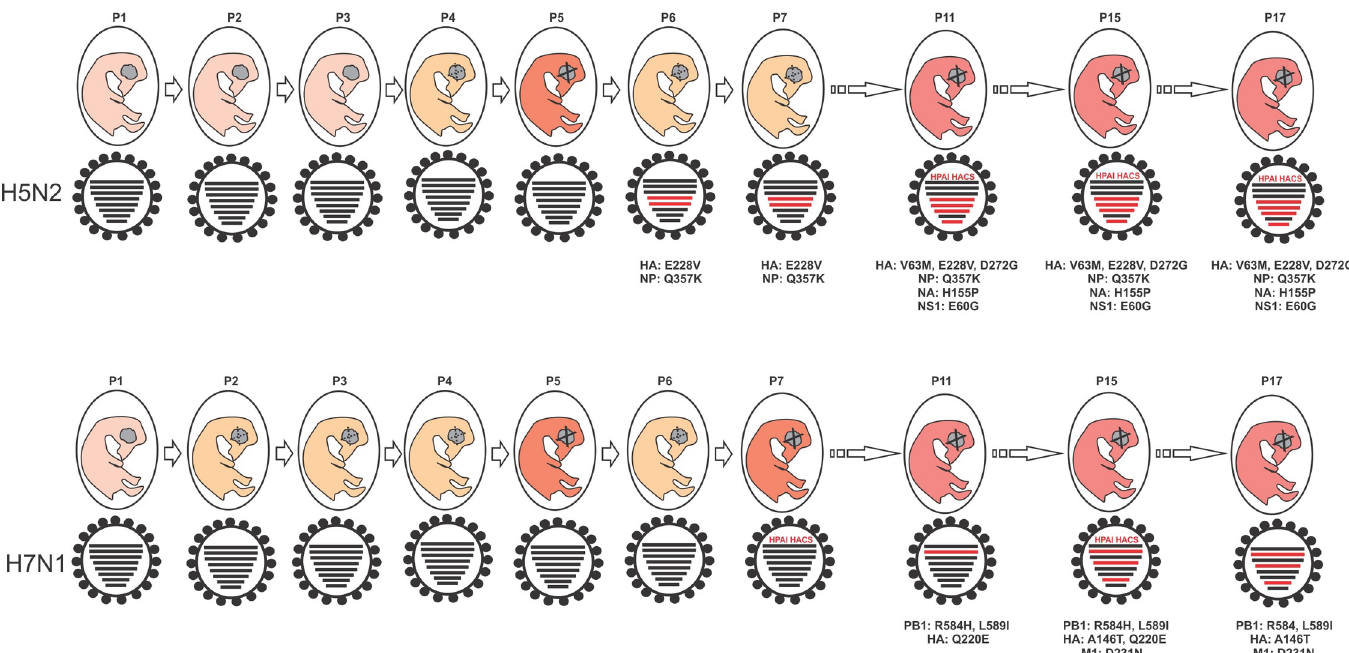
Fig 2. Schematic overview of the pathogenicity of H5N2 and H7N1 LPAI viruses, the emergence of potential virulence markers and the detection of multi-basic hemagglutinin cleavage sites (MB HACS) in the viral sub-population after seventeen passages in 14-day old ECEs. Pink embryos indicate mean death times (MDTs) with 100% survival to 90 h, yellow embryos with dotted lines indicate partial survival and/or MDTs between 60 and 90 hours, and red embryos with solid lines indicate 100% mortality within 60 hours or less. Red genome segments indicate one or more amino acid substitutions in the consensus protein sequence with key amino acid substitutions listed below the